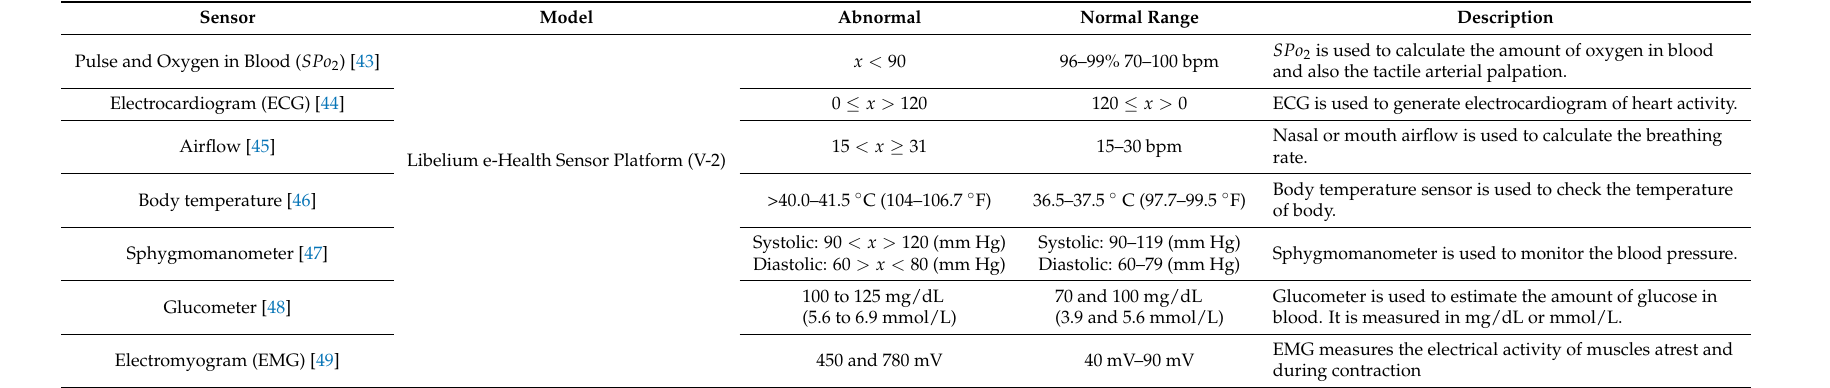
Table 4. Details of healthcare sensor used in experimental